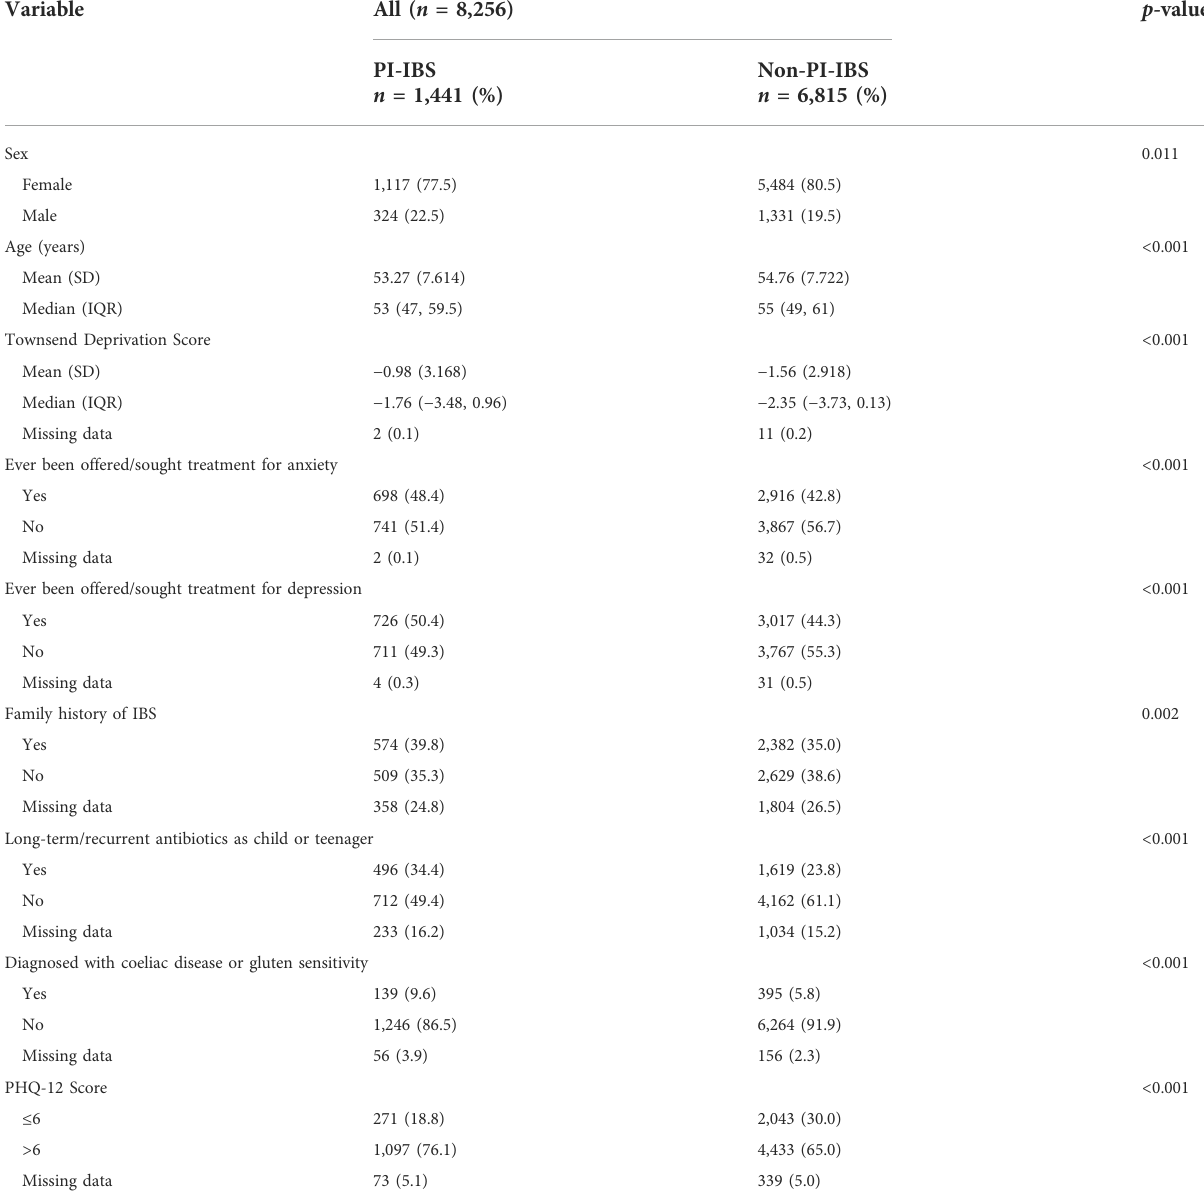
TABLE 3 Differences between PI-IBS and non-PI-IBS.